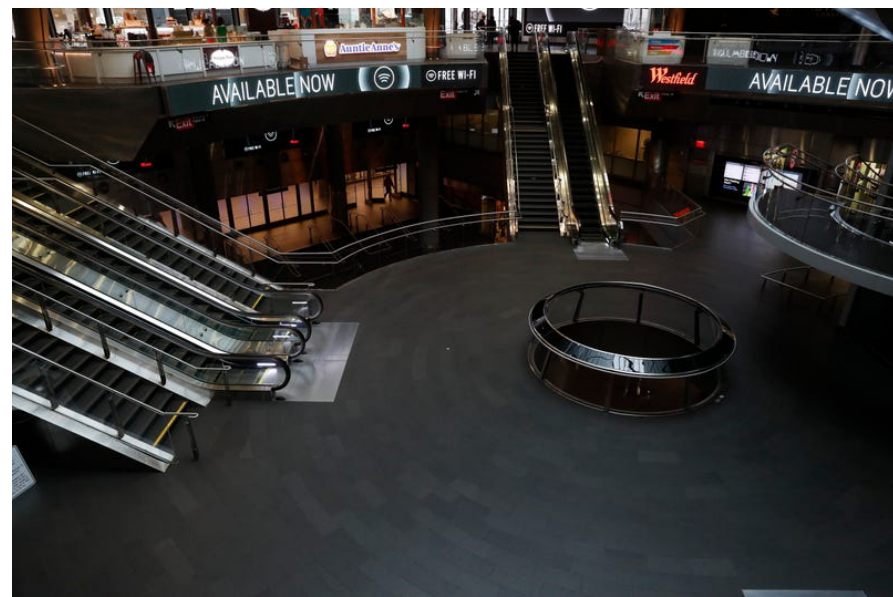
Figure 1. People enter a nearly empty Fulton subway station during the evening rush, as people react to coronavirus disease in New York City, U.S., 18 March 2020 [6].